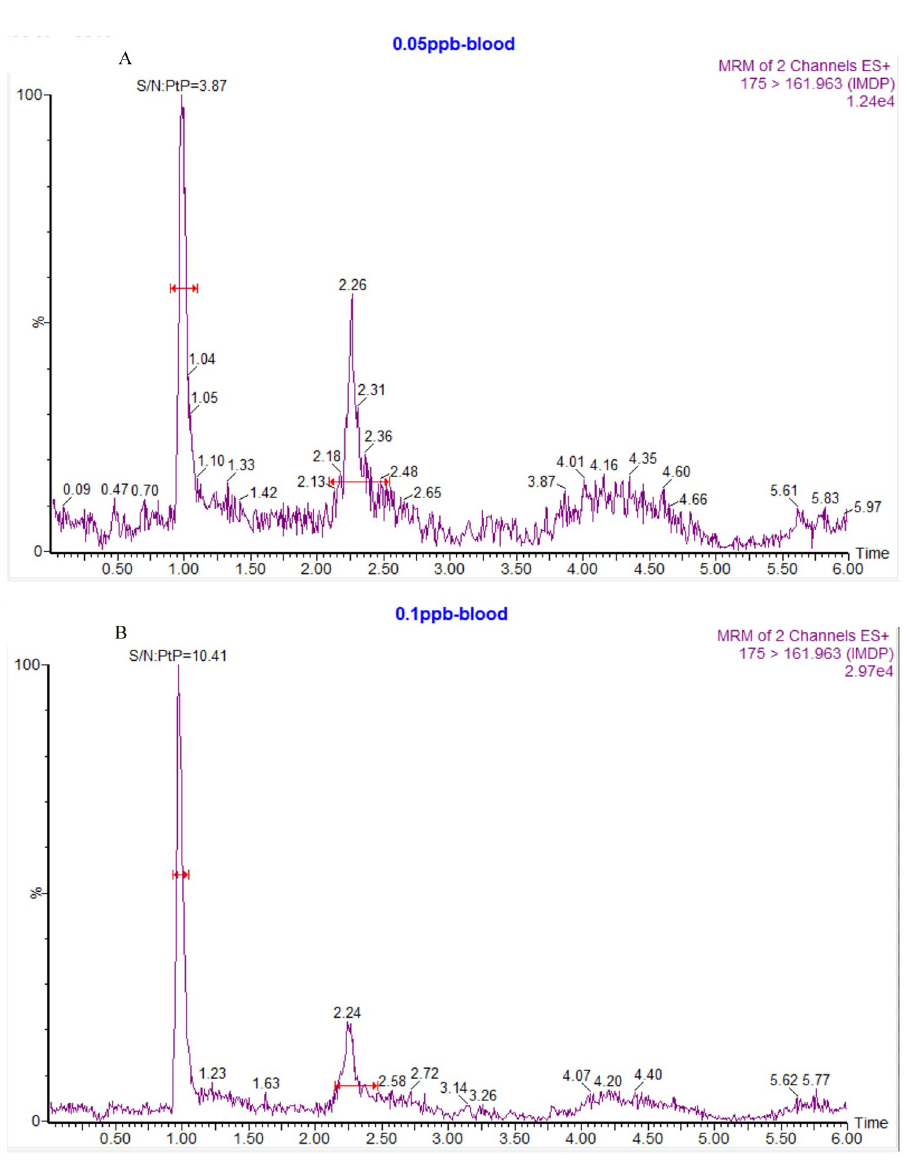
Fig 2. UPLC-MS/MS chromatograms. (A) LOD, (B)